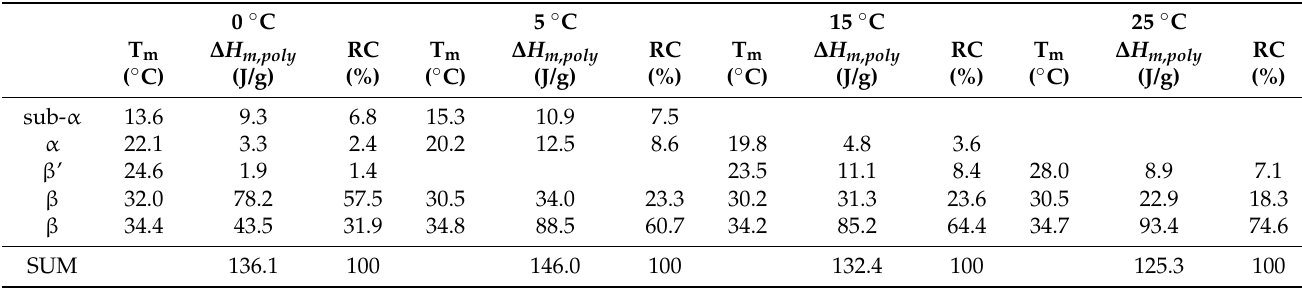
Table 6. Melting temperature and enthalpy of different polymorphs, as well as relative contribution (RC) of the total melting enthalpy, obtained by deconvolution of the DSC results of tempered cocoa butter.